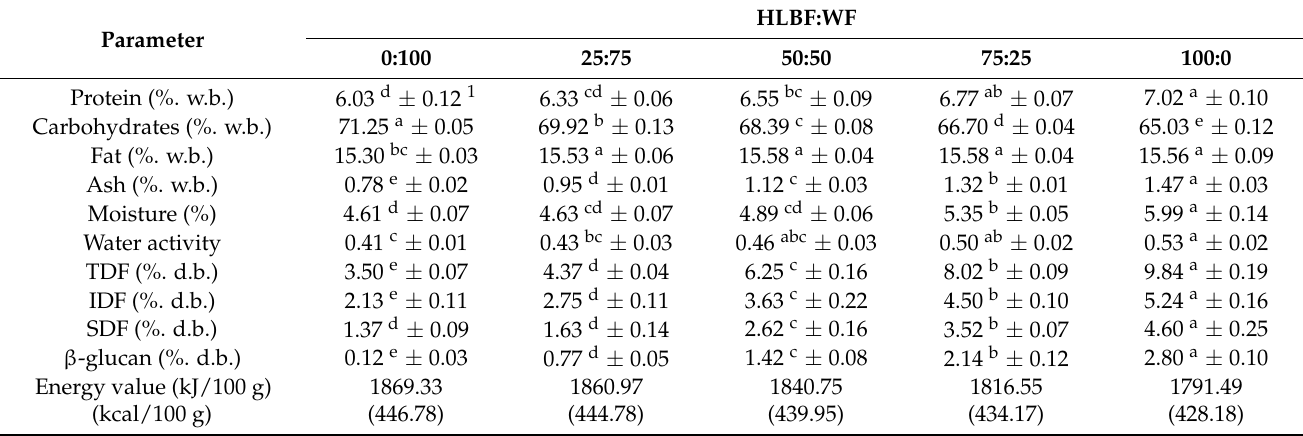
Table 4. Proximate composition, water activity ( a w ), total, insoluble, and soluble dietary fiber (TDF, IDF, SDF) content, and energy value of composite cookies containing wheat flour (WF) and hulless barley flour